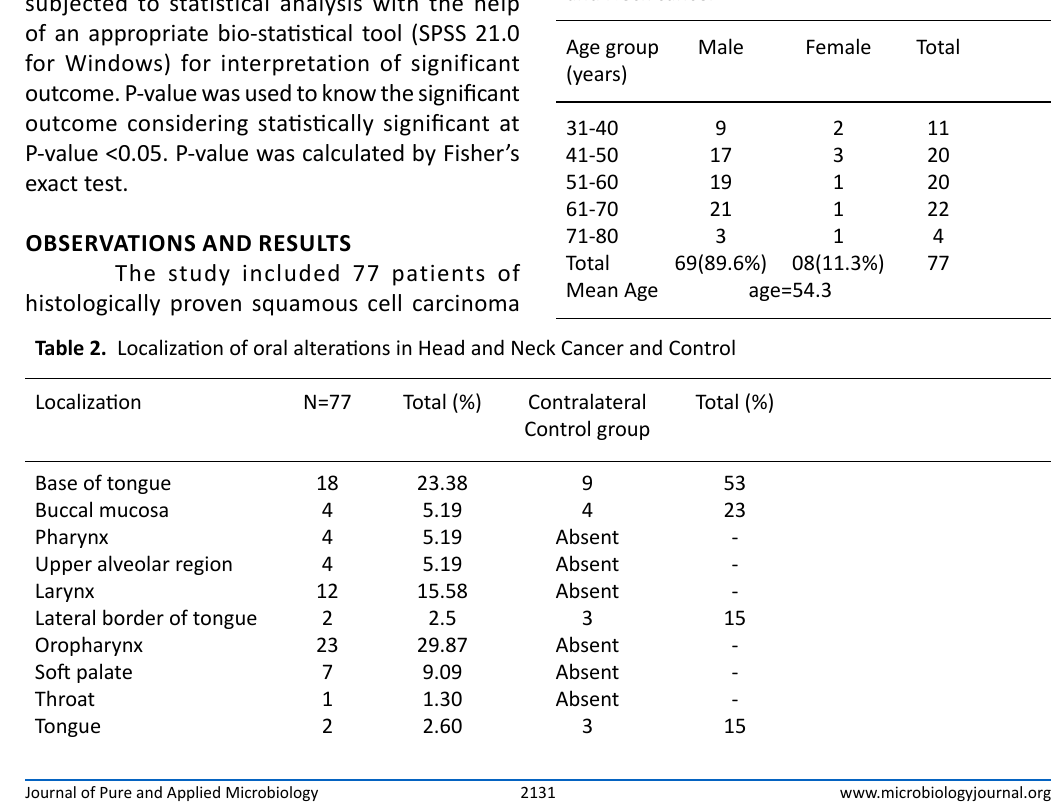
Table 1. Demographic distribution of patients of